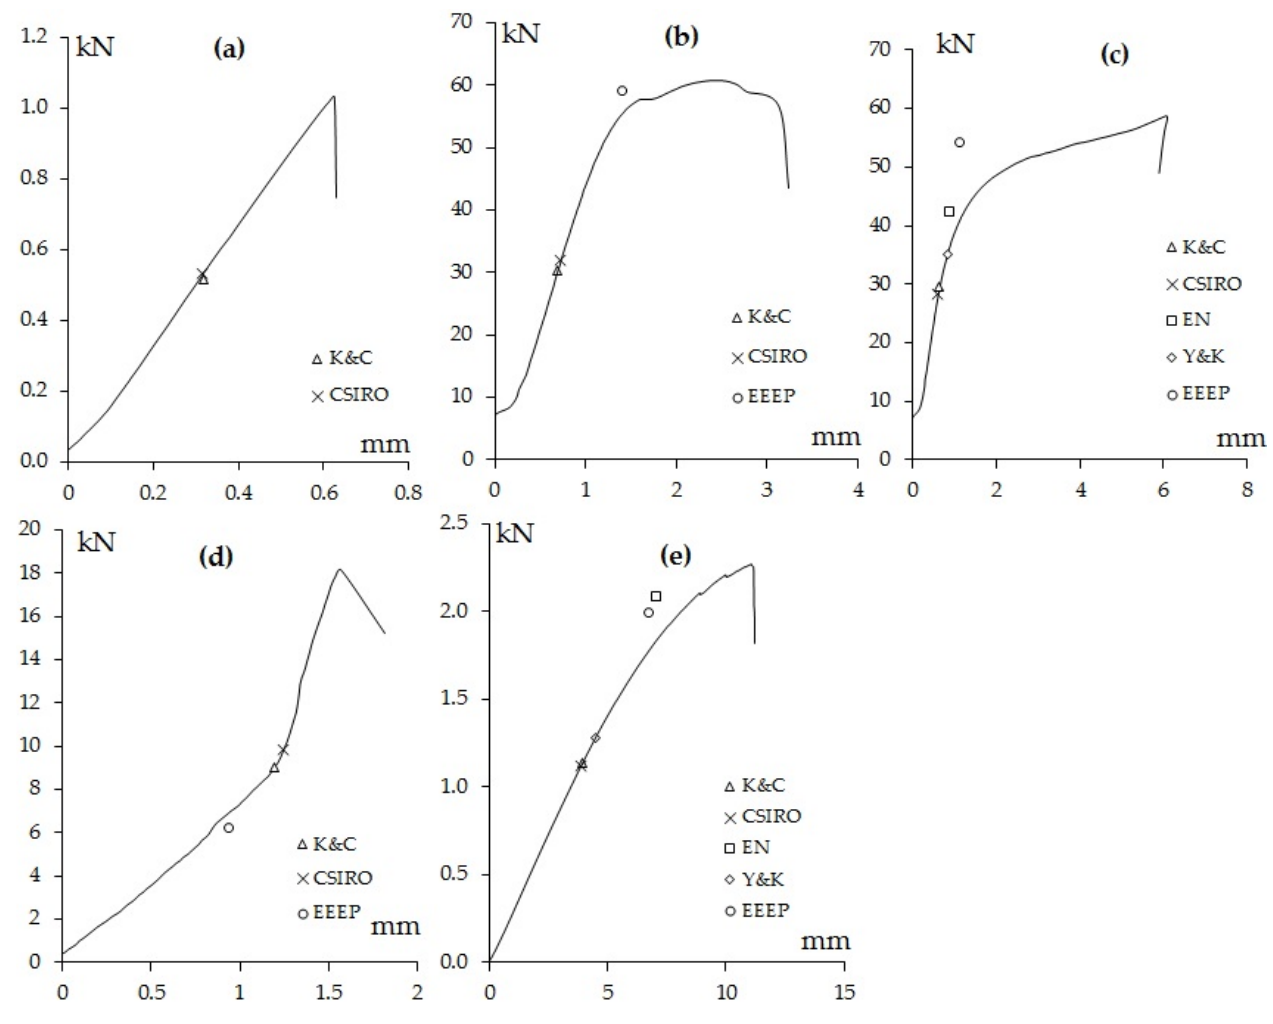
Figure 11. Position of yield points on the load-deformation curve of ( a ) tension parallel-to-fiber, ( b ) compression parallel-to-fiber, ( c ) compression perpendicular-to-fiber, ( d ) shear, and ( e ) flexural in bamboo scrimber.